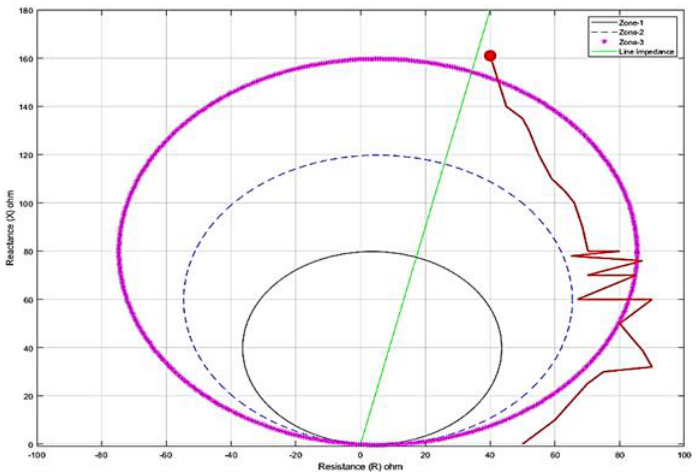
Figure 11. Distance relay characteristics under power swing conditions.